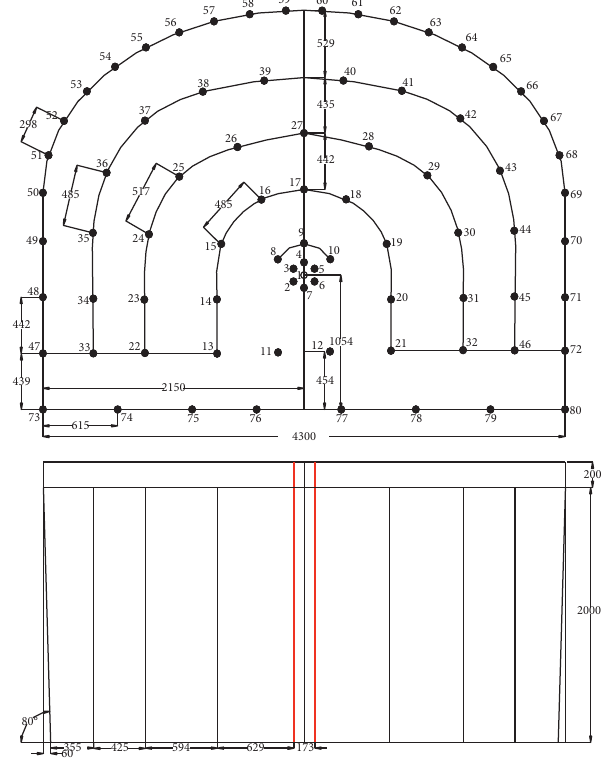
Figure 1: Blasting hole layout